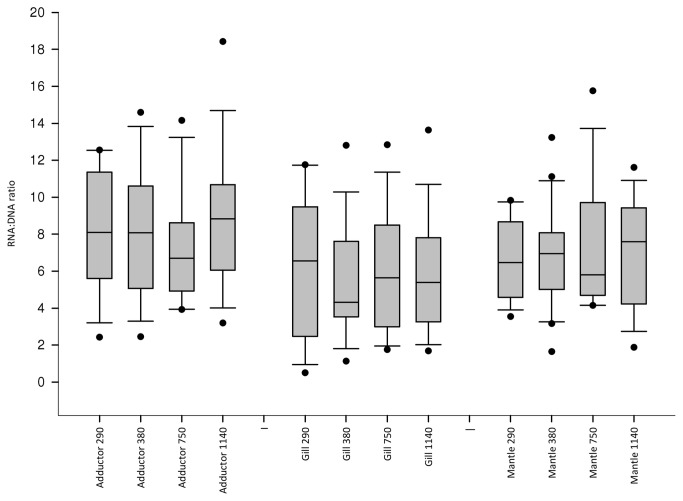
Effect of pCO2 on the RNA: DNA ratio of juvenile P. maximus.
RNA: DNA ratios are presented in adductor muscle, gill and mantle tissue denoted on the X axis in preset pCO2 (µatm) (left to right n=6,17,18,17,16,16,17,19,16,17,20,17).